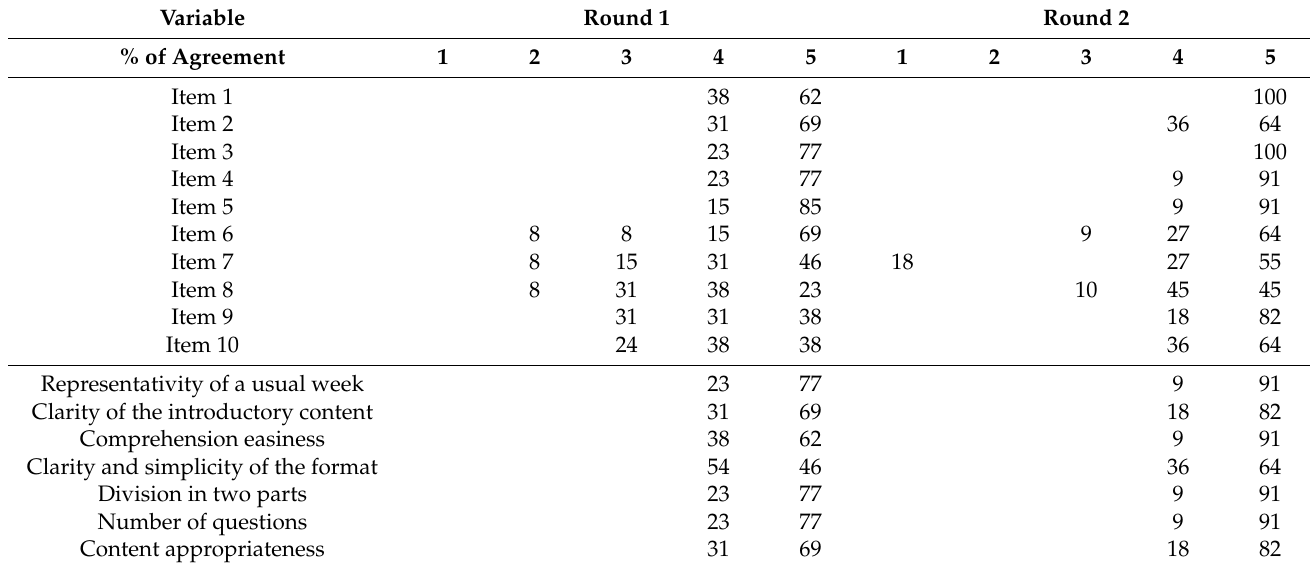
Table 2. Response rates for each of the items and general